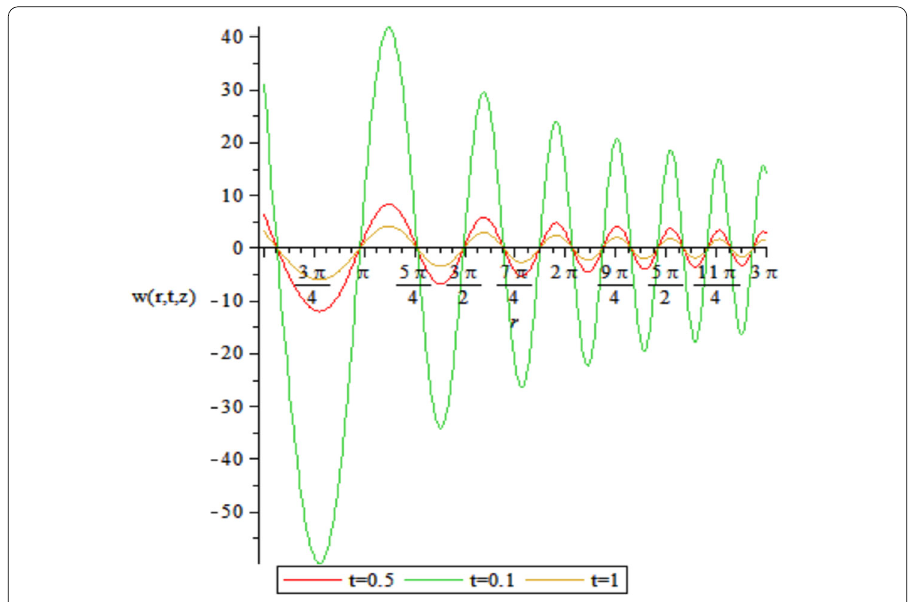
Figure 5 Velocity component w ( r , t , z ) at z = 2, c 1 = 1, c 3 = 1, and c 4 = 2